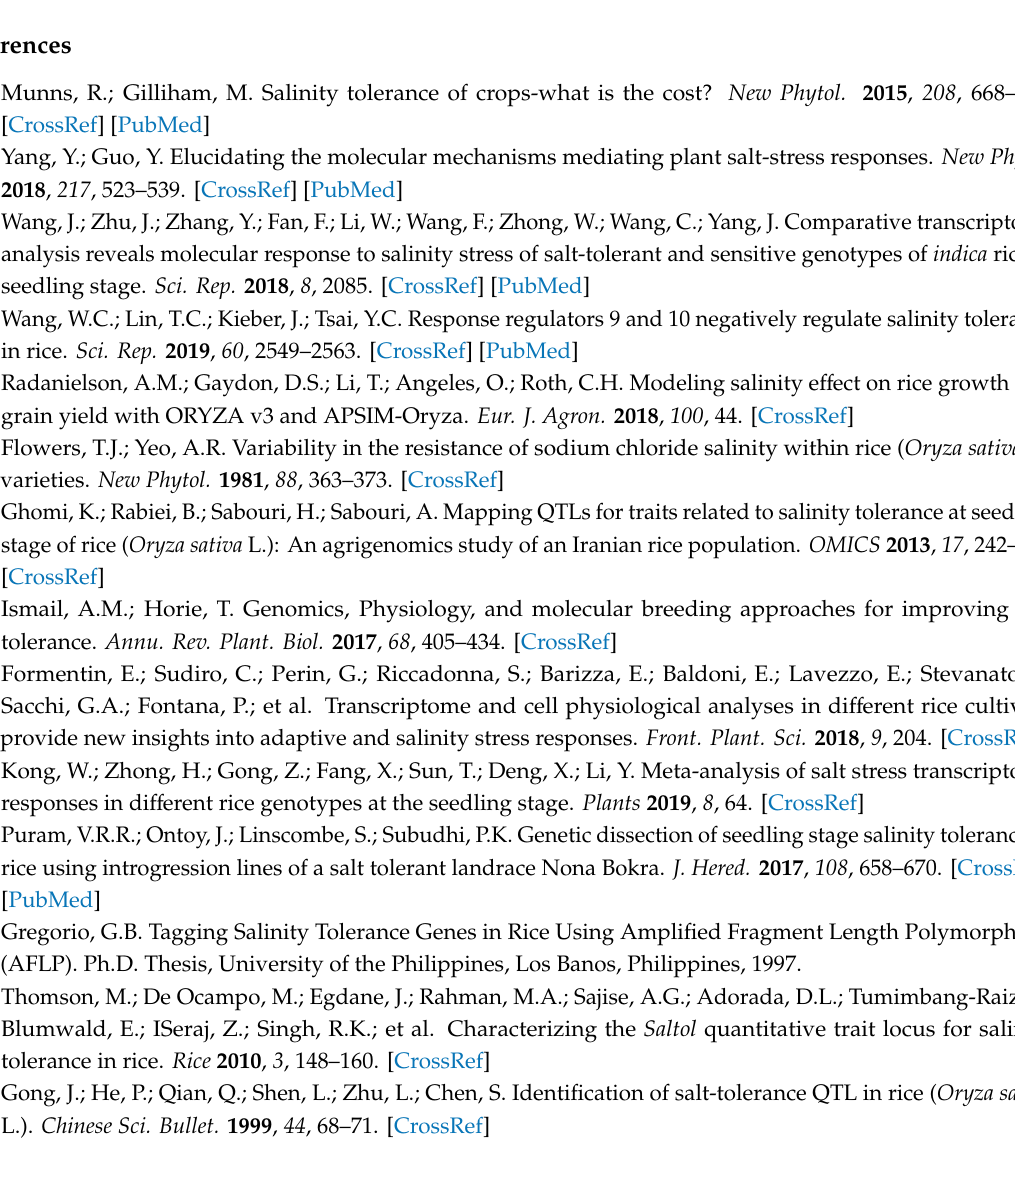
and the blue dotted line is the trendline. The yellow triangles represent the sample solution, the sample was diluted 5 times and determined, Figure S4: Sequence alignment of SKC1 ( OsHKT1;5 ) protein in SR86, Nona Bokra, DJY1, and YJ26. The dark blue shows the di ff erent sites, Table S1: Grading standard of salt tolerance on the relative salt damage rate, Table S2: SSR marks tested in this study, Table S3: The phenotypic frequency statistics of F 2 population under 1.2% NaCl treatment, Table S4: Data quantity and quality of whole-genome resequencing, Table S5: Sequencing depth and coverage statistics of whole-genome resequencing, Table S6: SNP statistics of whole-genome resequencing, Table S7: Indel statistics of whole genome and coding regions, Table S8: Classification and statistics of di ff erential genes produced by various mutations, Table S9: The qST1.1 a ff ected salt tolerance in F 2 at the seedling stage, Table S10: Di ff erent length homozygous overlapping segment lines screened from BC 2 F 3